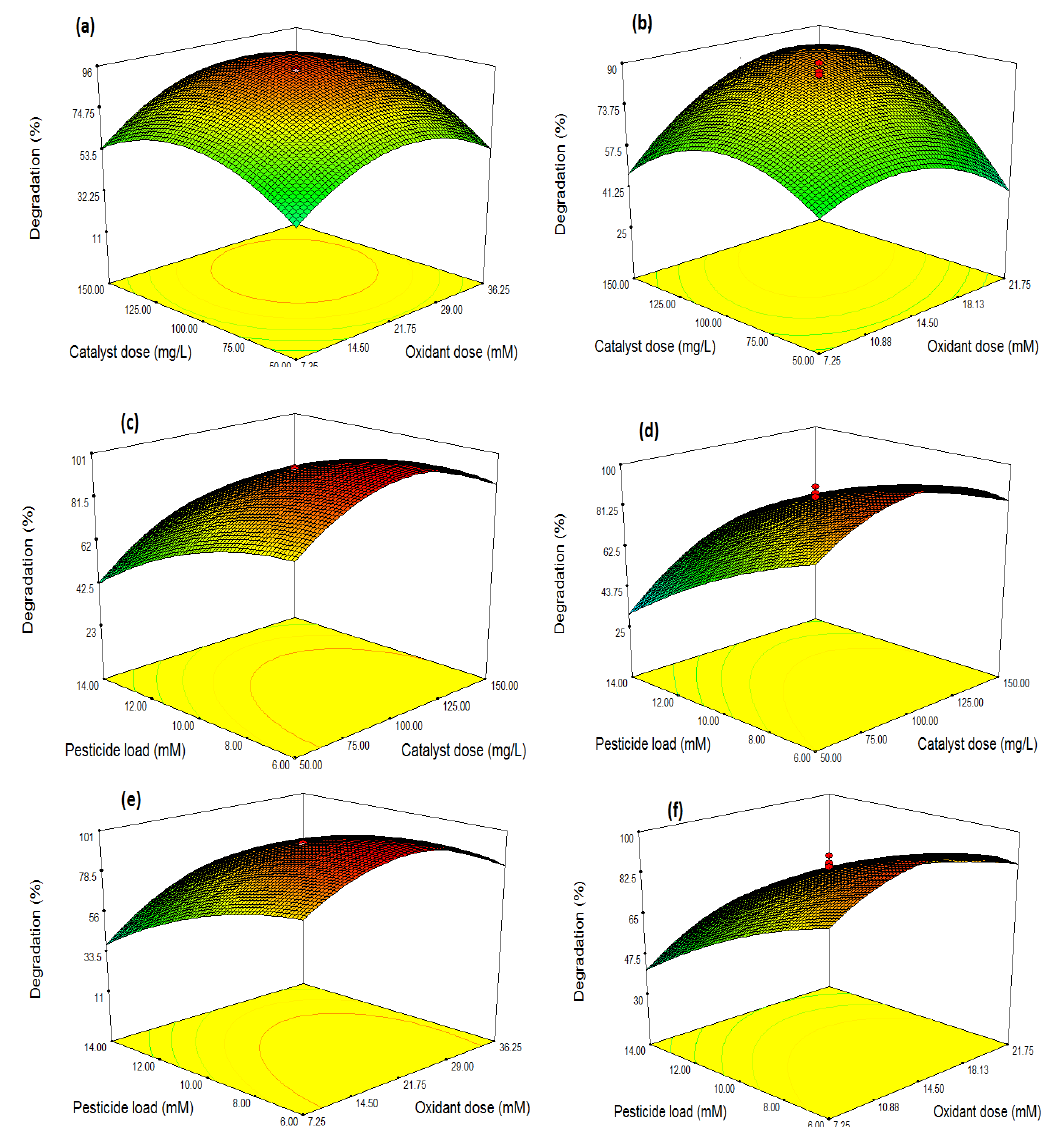
Figure 6. Response surfaces showing the combined effect of ( a,b ) oxidant dose and catalyst dose, ( c,d ) Catalyst dose and pesticide load, ( e,f ) oxidant dose and pesticide load on the degradation of acetamiprid, ( a , c , e ) using GO-Fe 3 O 4 and ( b , d , f ) using GO-CoFe 2 O 4 .